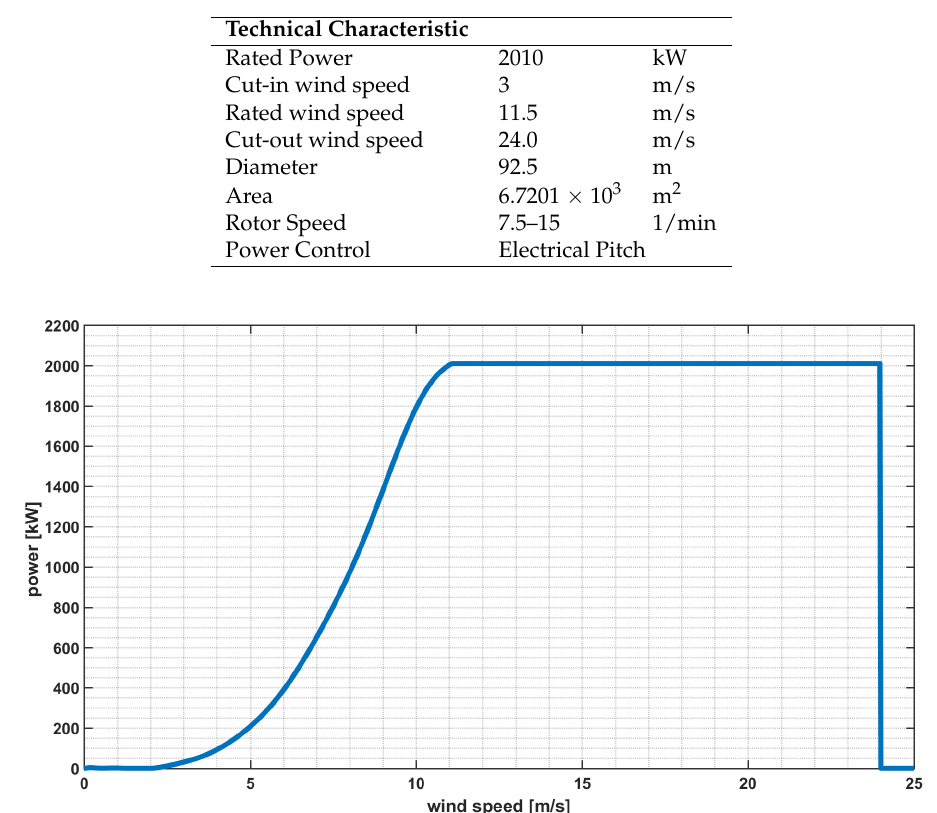
Figure 5. Manufacturer